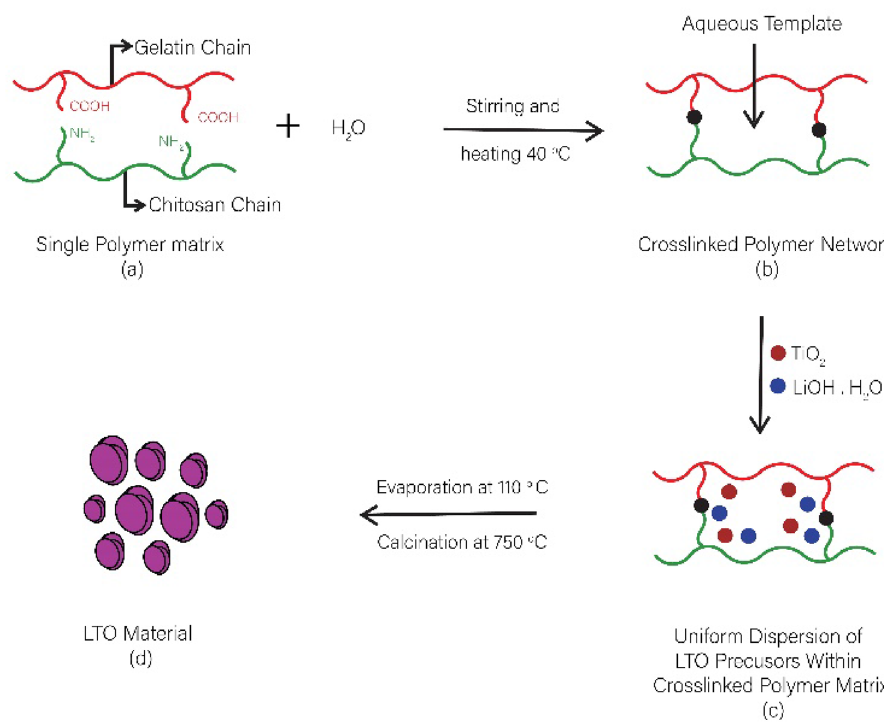
Fig. 1 Schematic diagram for the preparation of